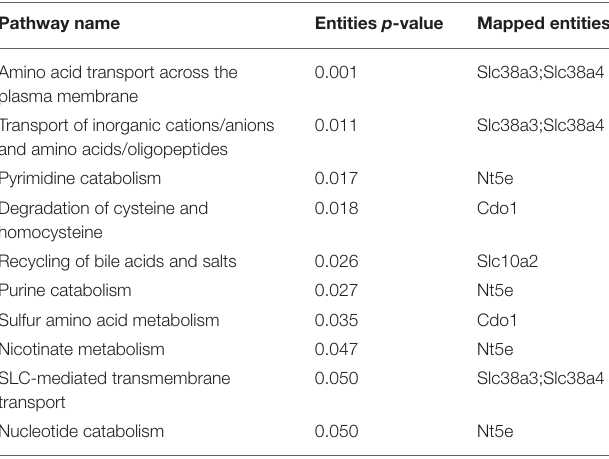
TABLE 1D | Top pathways associated with downregulated proteins (listed in Table 1C ) altered with